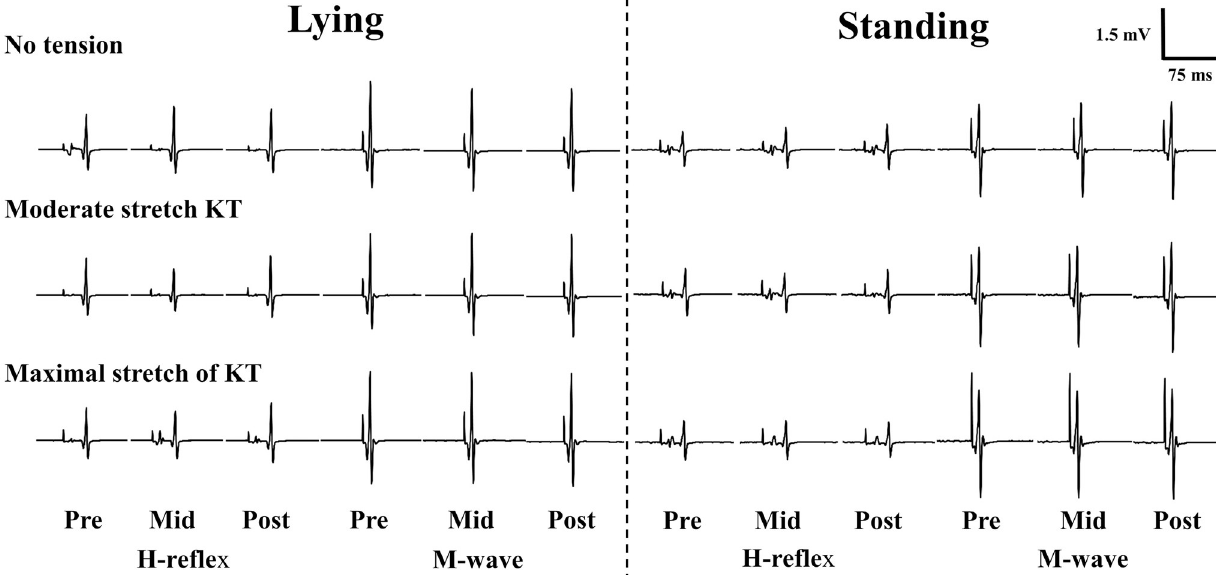
Fig 2. The example of a participant’s H-reflex and M-wave recoding tracings before (Pre), during (Mid), and after (Post) different KT intensities at the lying (A) and standing (B) postures.